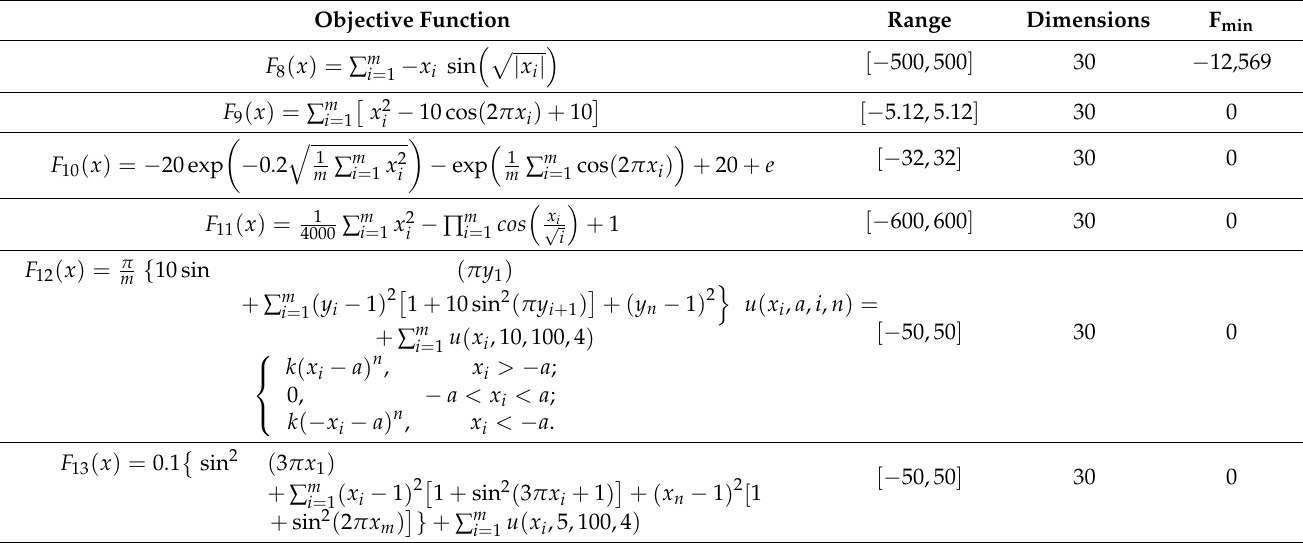
Table A2. High-dimensional multimodal test